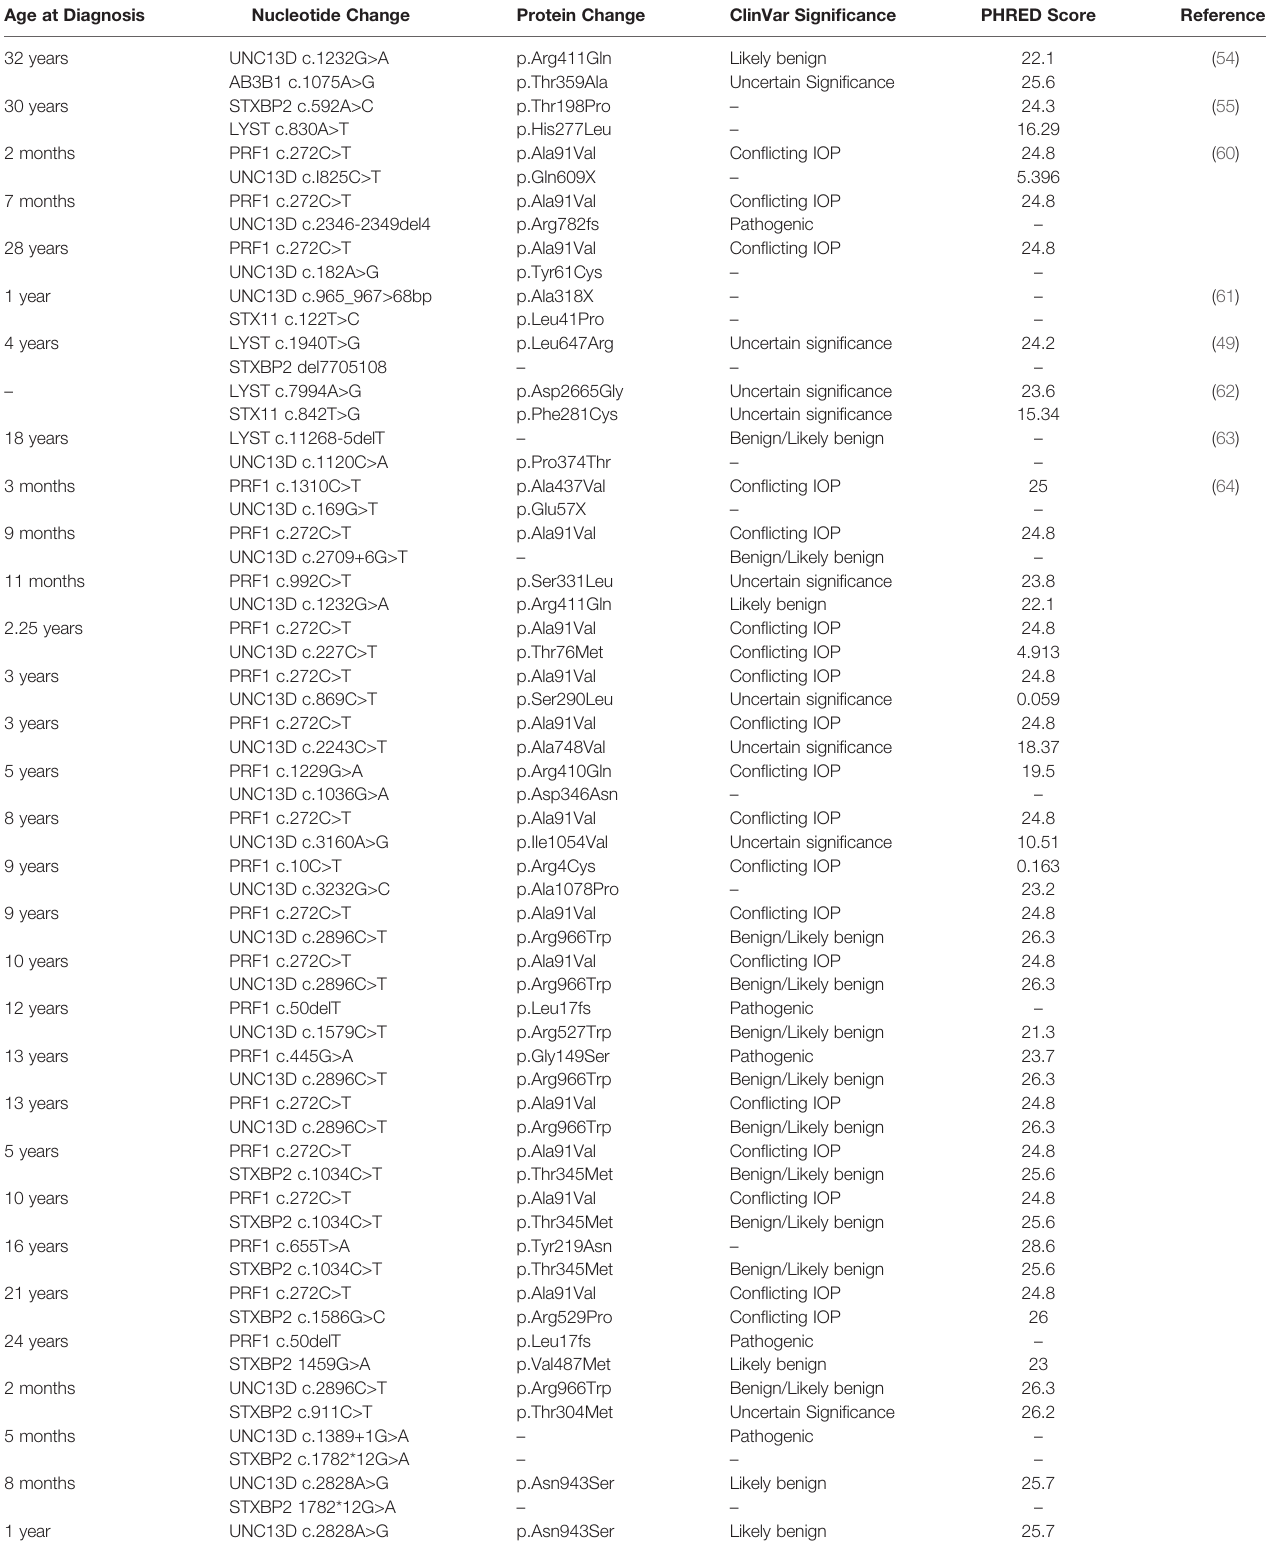
TABLE 2 | Summary of Clinical Data of Patients with DI of Degranulation Pathway Gene